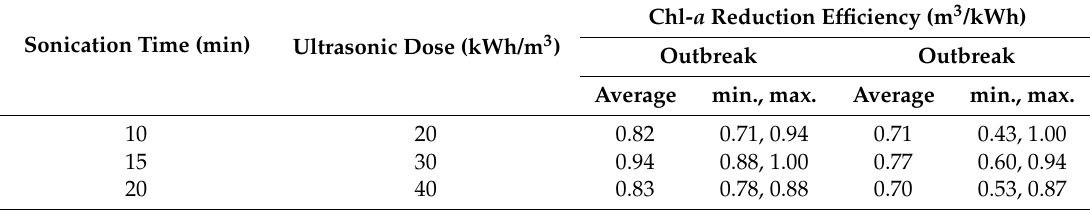
Table 2. Sonication efficiency in Chl- a reduction right after exposure